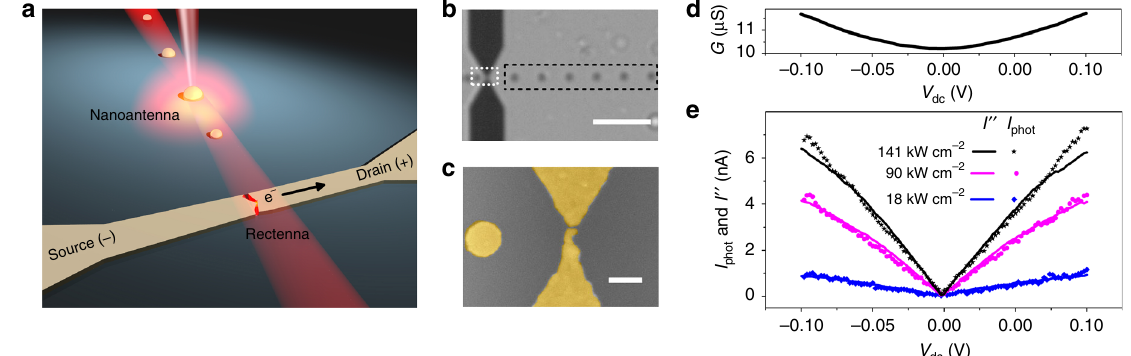
Fig. 1 Concept and device characterization. a Schematic illustration of the optical wireless transducing link: a dipolar optical antenna is excited by a focused laser beam. The energy radiated by the transmitter antenna is detected and converted to an electrical signal by a distant electrically biased receiving rectenna. b Optical transmission image of the functional units. The white dotted box highlights the feed-gap of the rectenna and the black dotted frame contains a series of transmitter optical antennas placed at different distances from the rectifying gap. Scale bar is 4 μ m. c Colorized SEM image of the region highlighted by the white dotted rectangle in b featuring a rectifying nanoscale feed-gap between two gold electrodes. Gold is colorized in yellow. Scale bar is 250 nm. d Evolution of the conductance G of the tunnel feed-gap with V dc . e Plot of the variation of the amplitude of the recti fi ed photocurrent I ’ s conductance I ” = 1/4( V 2 ∂ 2 I / ∂ V 2 ) (line plots) as a function of applied phot (data points) and of the current proportional to the nonlinearity of the junction ac bias V dc and for three direct excitation intensities of the rectenna illuminated by a focused 785 nm laser. The shared trends between I phot and I ” con fi rm